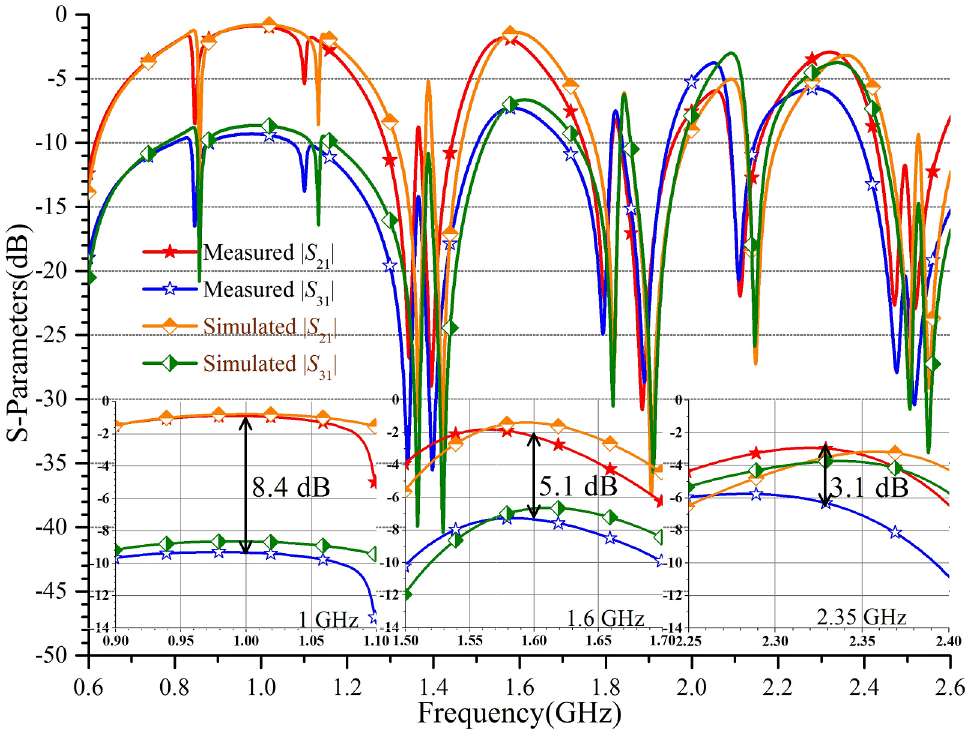
Fig 7. The insertion loss responses of the TTPD. The simulatedand measuredcoefficient | S 21 |, | S 31 | and the difference of | S 21 |-| S 31 | are given. The three sub-graphs extracted at three frequency points are given.